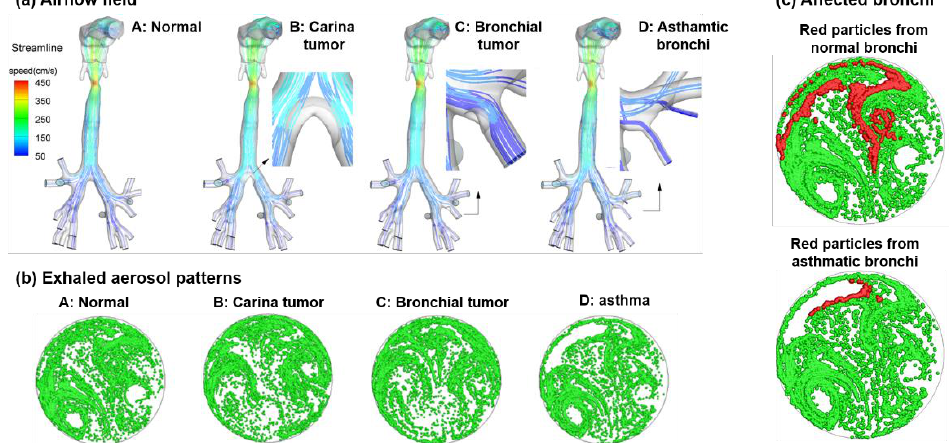
Figure 3. Proof-of-concept study in the upper airways: ( a ) airflow, ( b ) exhaled aerosol patterns, and ( c ) comparison of particles that were originally released from normal and constricted bronchi. One normal (Model A) and three diseased (Model B–D) were considered. The three diseases in the models B–D were carina tumor, bronchiolar tumor at G3 of the left lower lobe, and constricted bronchi in the left upper lobe (or asthma), respectively. Adapted from [57].